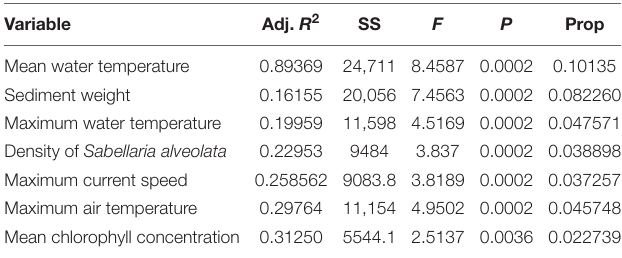
TABLE 3 | DISTLM marginal test results for each environmental predictor variable selected for the most parsimonious model for macrofaunal assemblages. Variable